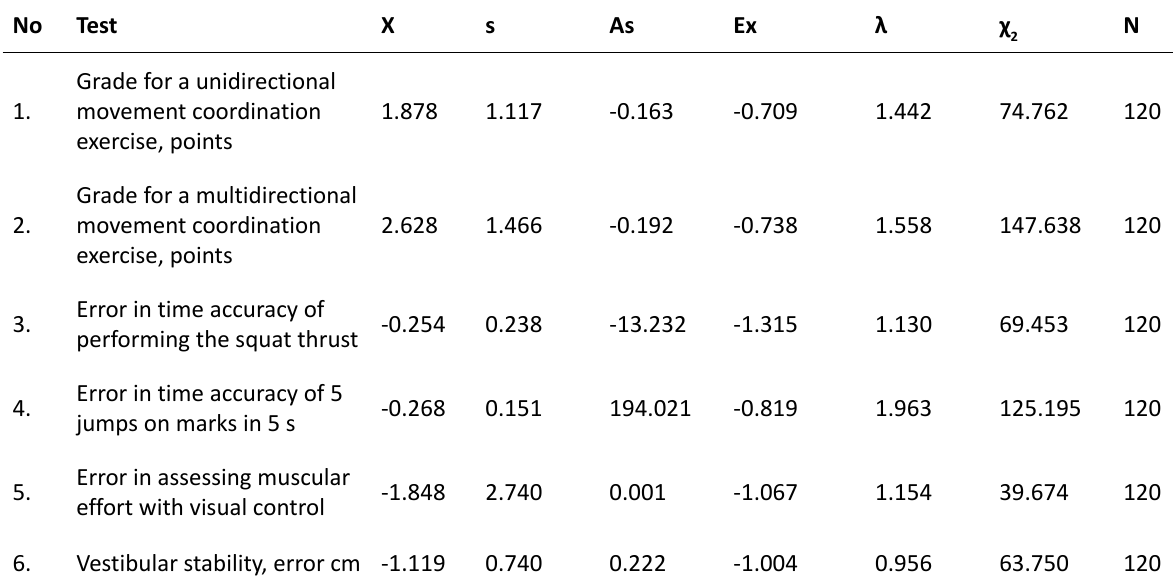
Table 4. Computational experiment results. Elementary statistics